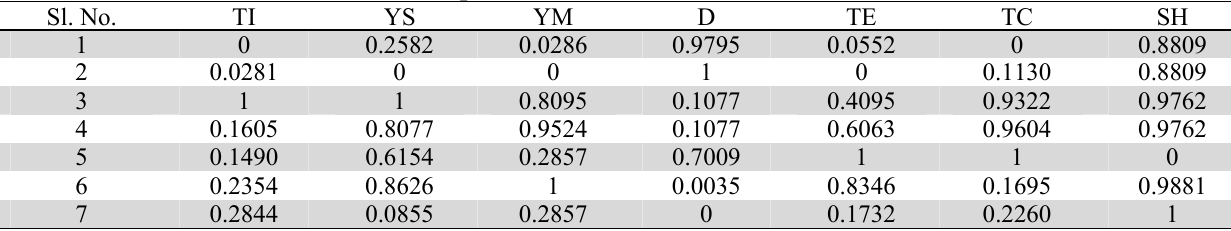
Normalized decision matrix for example 2 Sl. No.